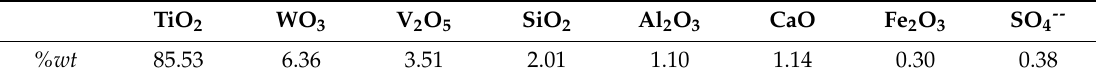
Table 1. Chemical composition of the fresh catalyst by XRF analysis.